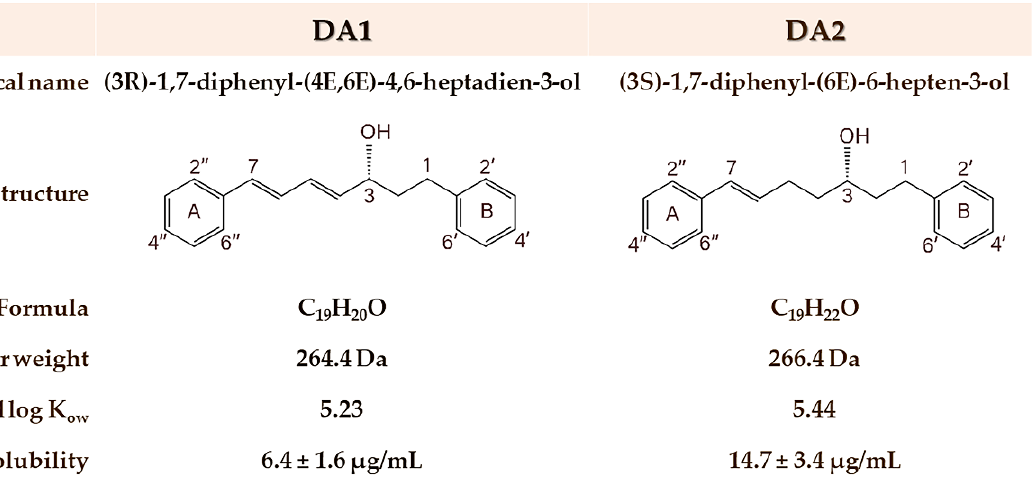
Figure 1. Structures and physicochemical properties of DA1 and DA2 presented in C. comosa extract. Log K ow refers to a log octanol/water partition coefficient calculated via KOWWIN v1.68 estimate. Water solubility at 37 °C is modified from Jaipakdee et al. [14].